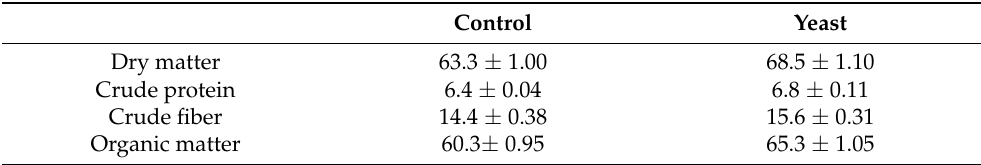
Table 4. Effect of adding S.C. supplementation on nutrient intake (g/kg B.W. 0.75 /day) of rams (means ± S.E.M.). Control Yeast Dry matter Crude fiber Organic matter 60.3 ± 0.95 65.3 ± 1.05 S.E.M.: standard error of the mean. Table 5. Apparent digestibility (%) and nitrogen balance (g/d) parameters (means ± S.E.M.). Control Yeast Dry matter digestibility (D.M.D.) 70.19 ± 0.90 a 75.30 ± 0.96 b Organic matter digestibility (O.M.D.) Crude protein digestibility (C.P.D.) Crude fiber digestibility (C.F.D.)